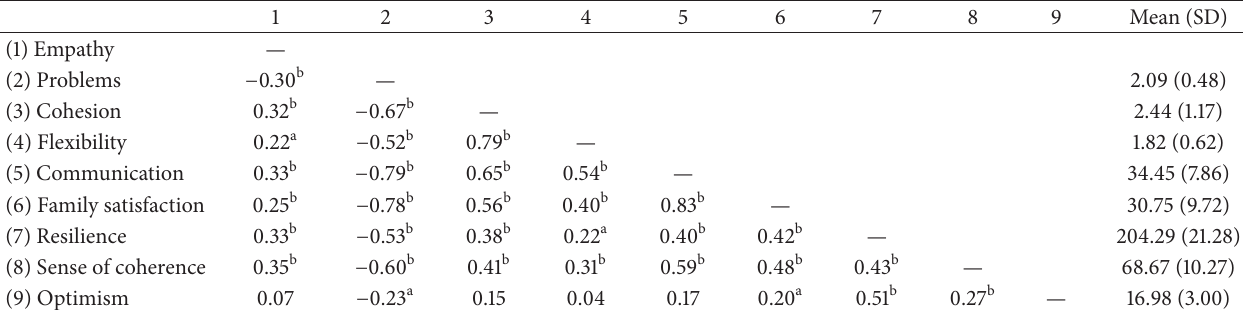
Table 2: Correlations between family dynamics and personal